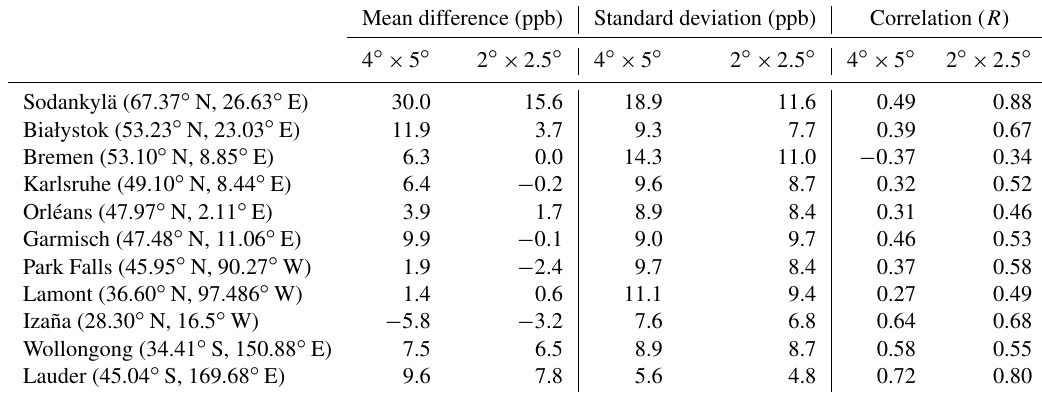
Table 1. Evaluation of a priori 4 ◦ × 5 ◦ and 2 ◦ × 2 . 5 ◦ resolution GEOS-Chem model fields against TCCON XCH 4 retrievals (mean station- wise statistics for the period of February–May